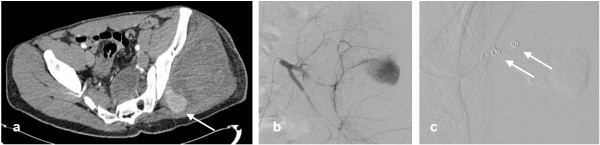
a) Axial arterial phase contrast enhanced CT in a 23 year old man following a stab wound to the left buttock demonstrates haematoma within the gluteus muscles. Contrast enhancement medially (arrow) represents active haemorrhage from the superior gluteal artery (Somatom sensation, 24 slice,Siemens, Erlangen, Germany). b) A Cobra catheter was negotiated into the posterior (somatic) left internal iliac artery from an ipsilateral approach. Active haemorrhage from a branch of the superior gluteal artery was demonstrated. c) A microcatheter system (Progreat) was negotiated into the bleeding vessel and 2 microcoils (Boston Scientific vortex fibred) were deployed (arrows). This completely abolished the bleeding with good perfusion of the buttock post procedure.